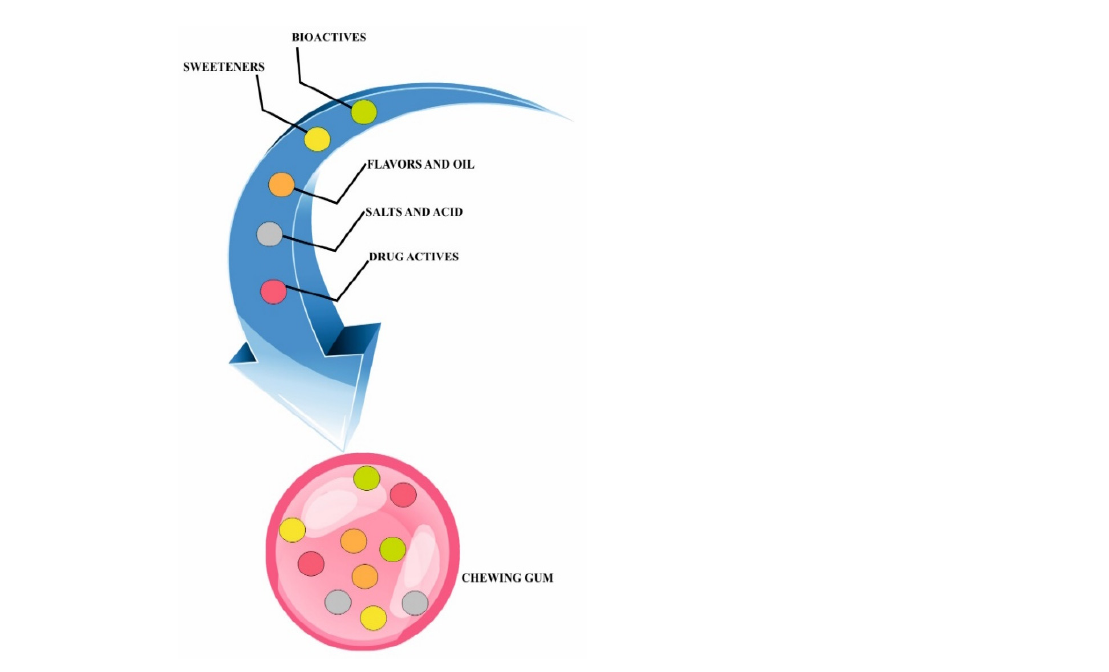
Figure 6. Graphic representation showing major ingredients employed in the formulation of encap ‐ sulated chewing gums. sulated chewing